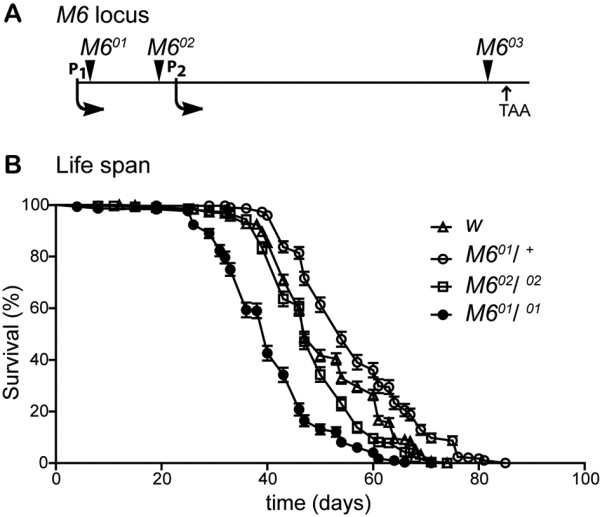
Median lifespan is reduced inM6mutant flies. (A) Schematic diagram (not drawn to scale) of the M6 locus showing the localization of independent P-element insertions (arrowheads). Start transcription sites corresponding to P1 and P2 and the stop codon (TAA) are also indicated. (B) Survival curves of adult w, M602/ 02, heterozygous and homozygous M601 males (M601/ + and M601/ 01, respectively). The percentage of surviving flies ± SE over time (in days) at 25 °C in LD (standard conditions) is shown. Statistical analysis included a Log-rank (Mantel-Cox) survival curve comparison (p < 0.0001; Graphpad Software). Sample size ranged between 292 and 496 flies per genotype.